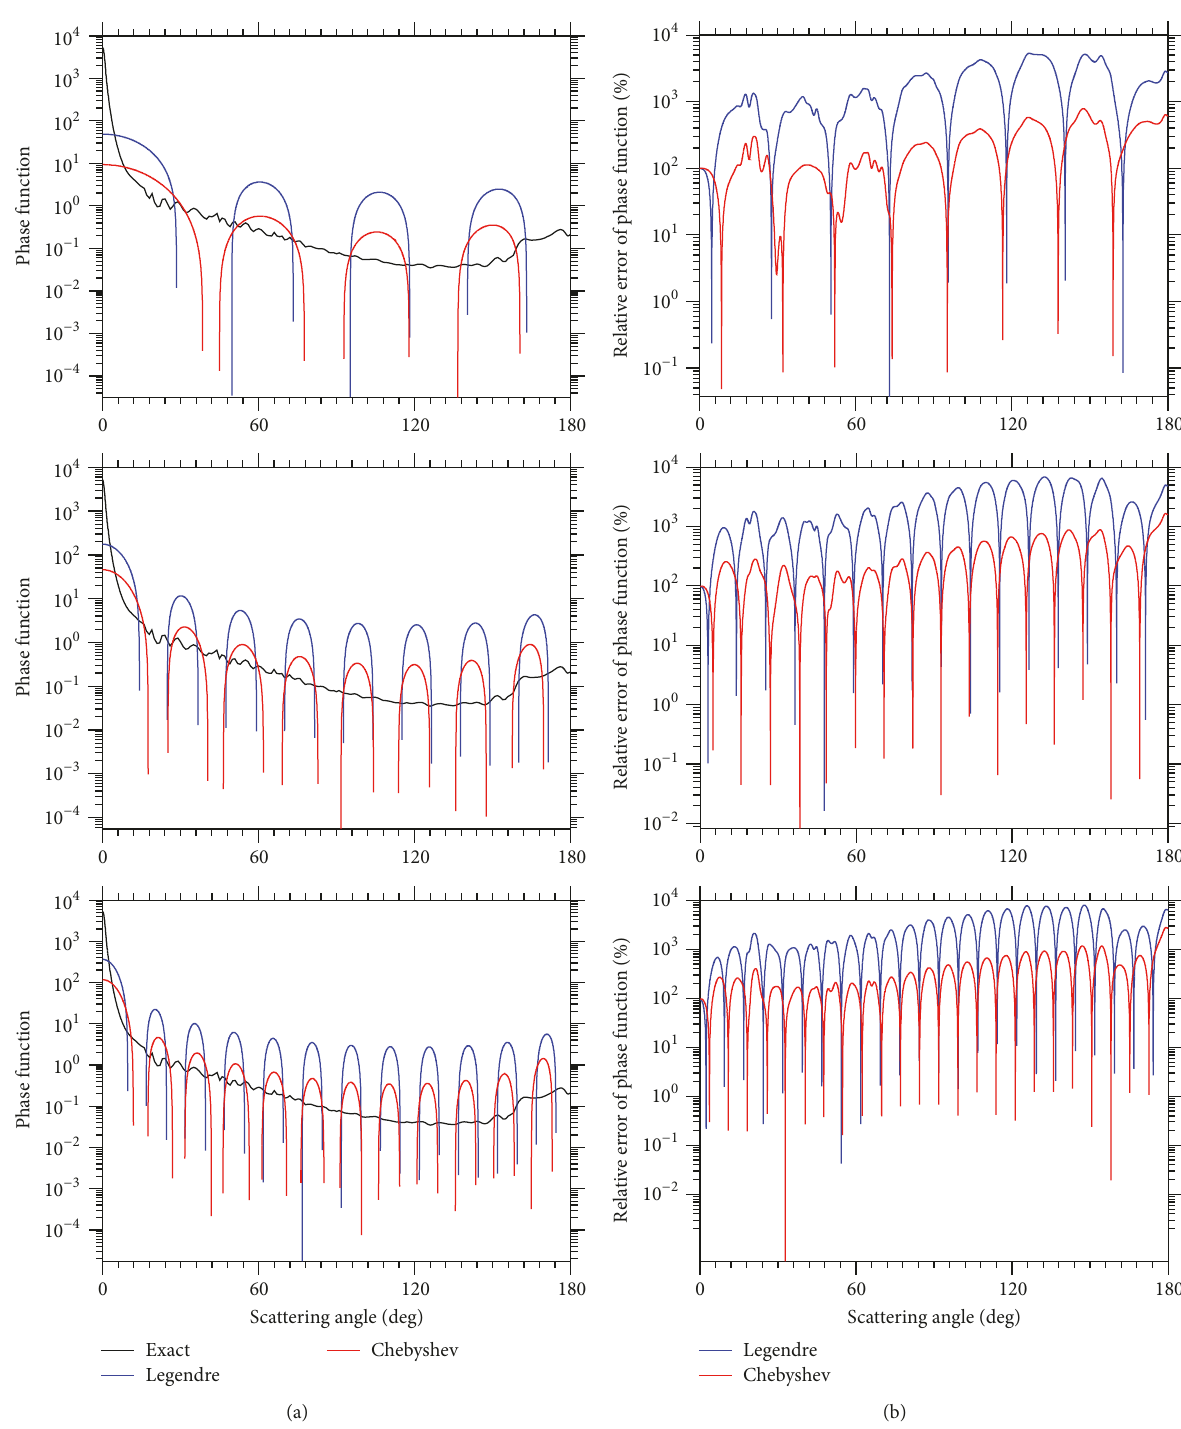
Figure 5: Phase function of coarse mode of dust (a) and relative error of phase function (b) in 8, 16, and 24